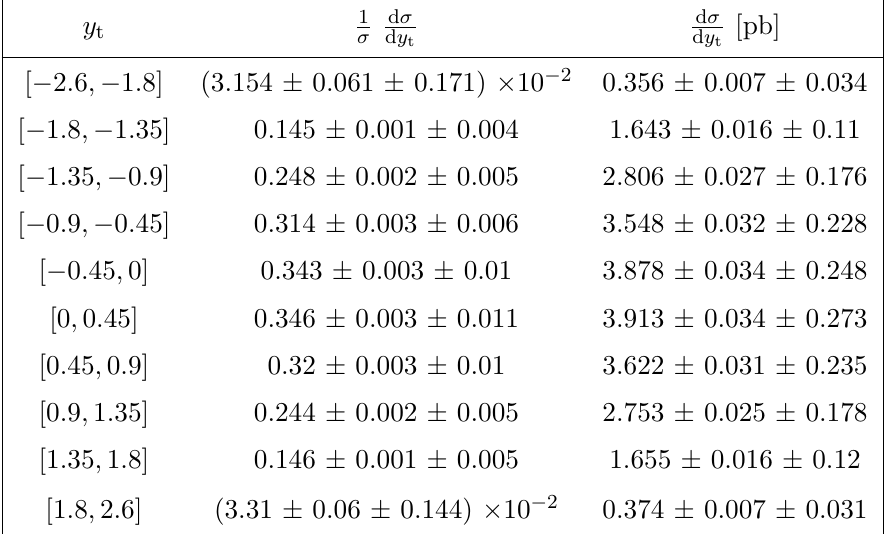
Table 20 . The measured di(cid:11)erential cross section and bin boundaries for each bin of the normalized and absolute measurements of the tt di(cid:11)erential cross section at particle level in the (cid:12)ducial phase space as a function of y t are tabulated.